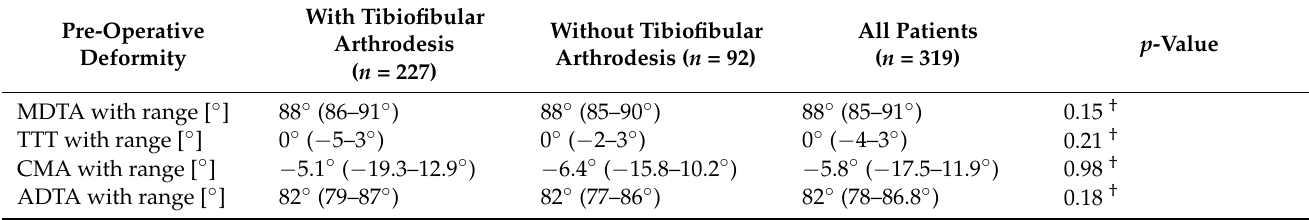
Table 2. Pre-operative deformity